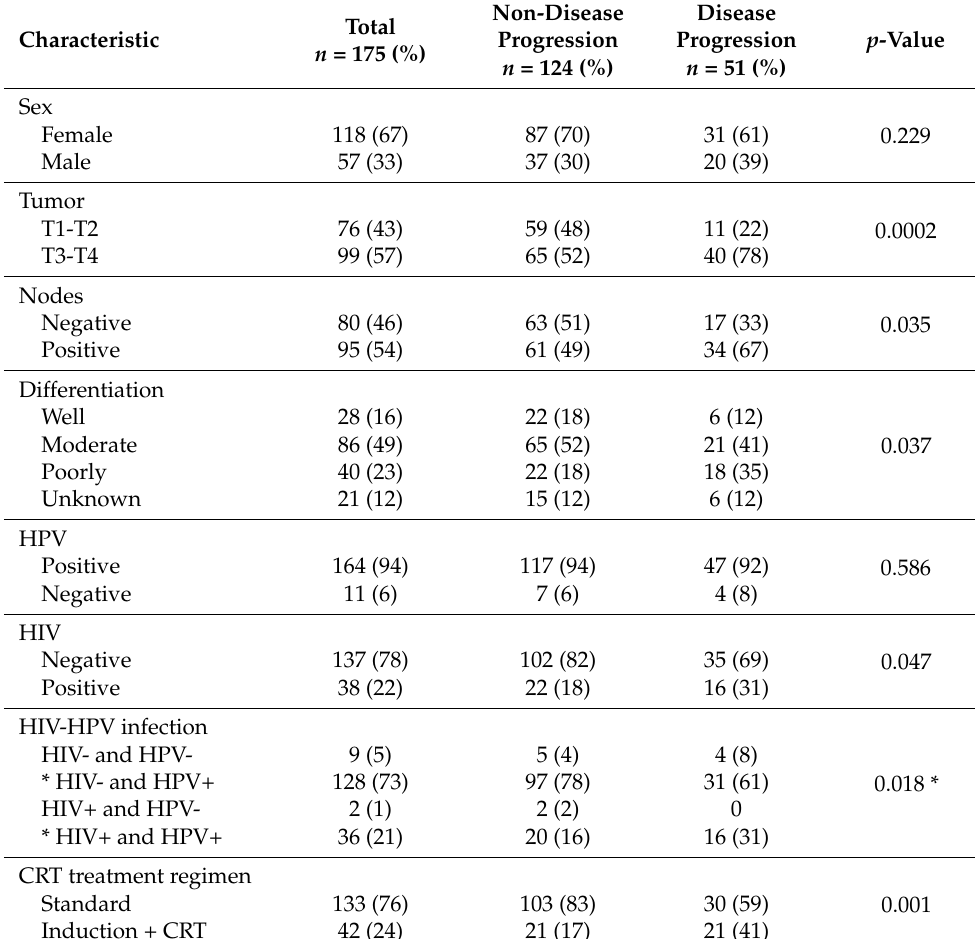
Table 2. Univariate analysis of disease-free survival (DFS) based on patient demographic, clinical and treatment